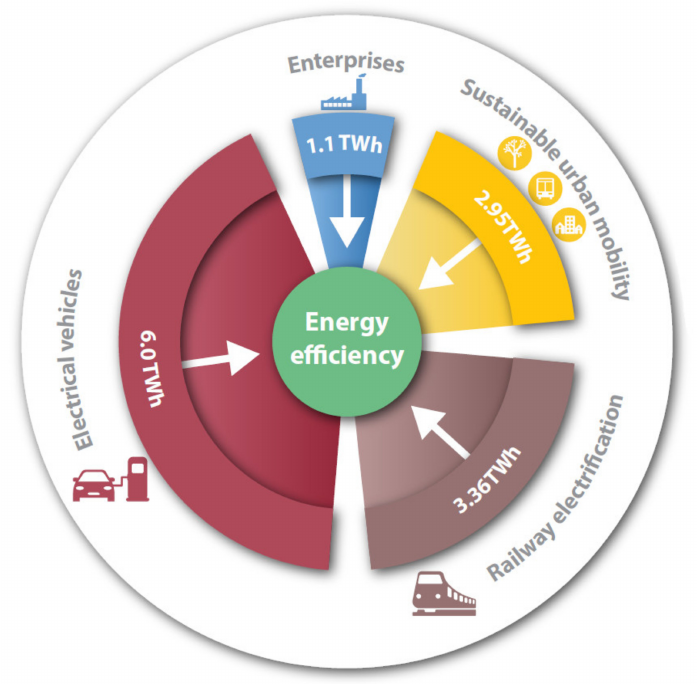
Figure 6. The main measures envisaged for energy